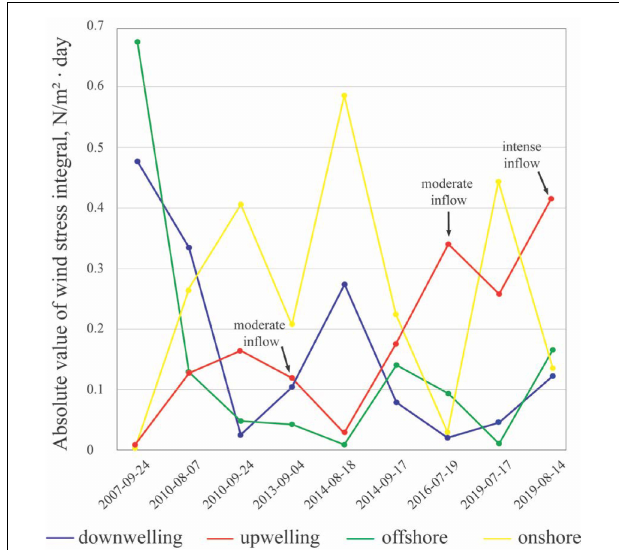
FIGURE 7 | The absolute values of time integrals of downwelling (blue), upwelling (red), offshore (green), and onshore (yellow) wind stress at the central part of the Kara Sea preceding the periods of in situ measurements. Black arrows indicate cases with moderate and intense